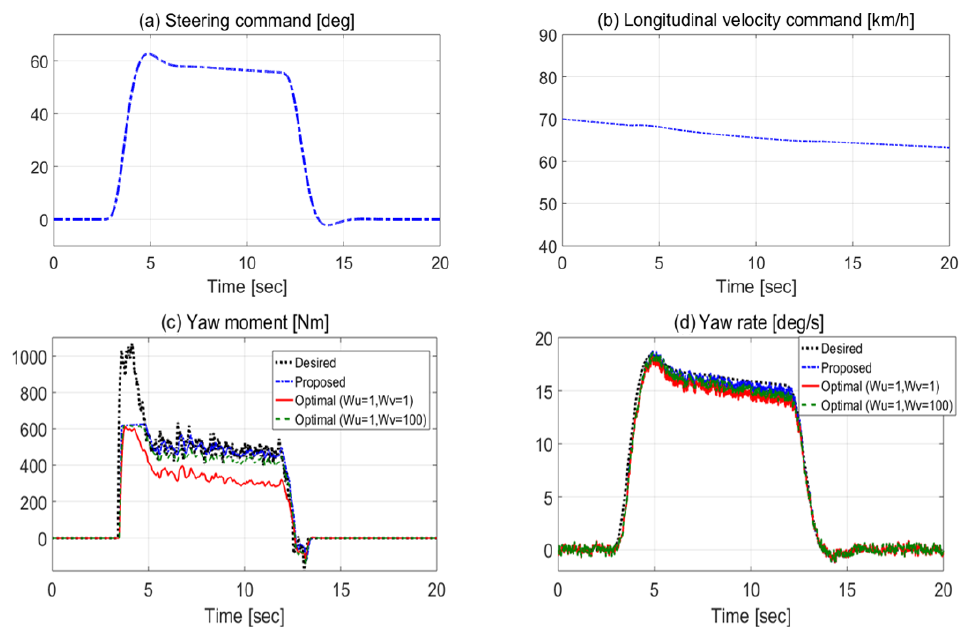
Figure 9. Simulation results of circle turn test (according to different 𝑊 𝑣 : (150 (proposed), 100, 1). ( a ) Steering command. ( b ) Longitudinal velocity command. ( c ) Yaw moment. ( d ) Yaw rate.